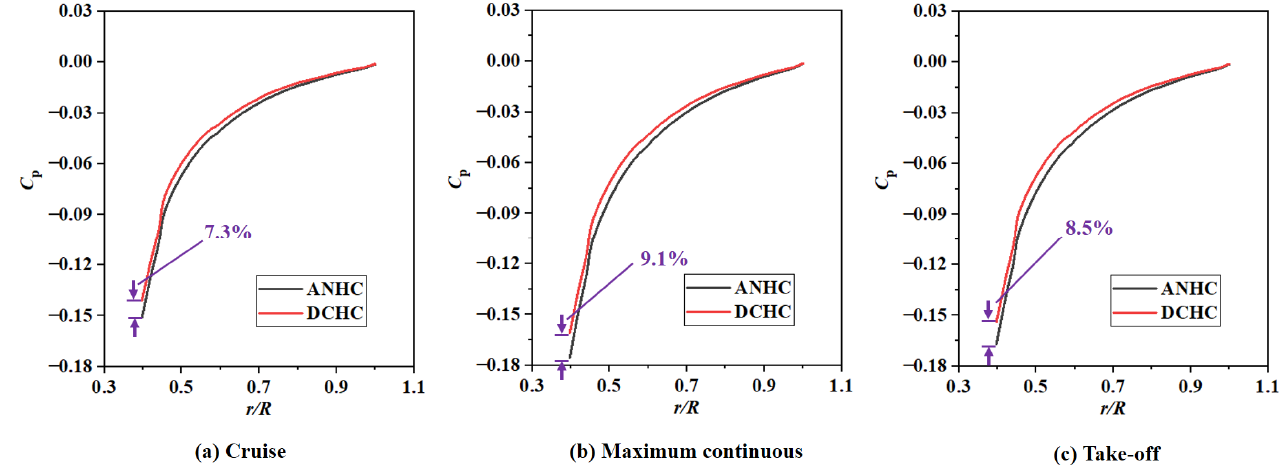
Figure 30. Pressure coefficient distributions of rotating disk surface under ANHC and DCHC.